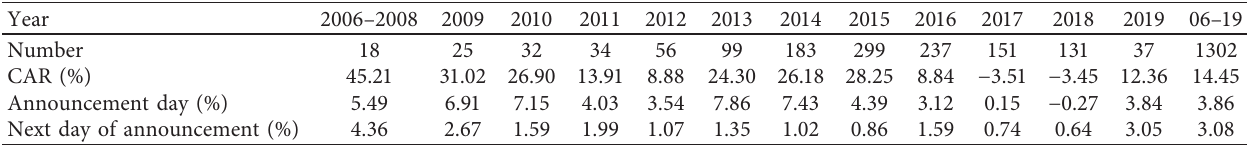
Figure 10: Significance test change in the window period. Table 6: Annual distribution of research samples (1302) and cumulative average abnormal return.